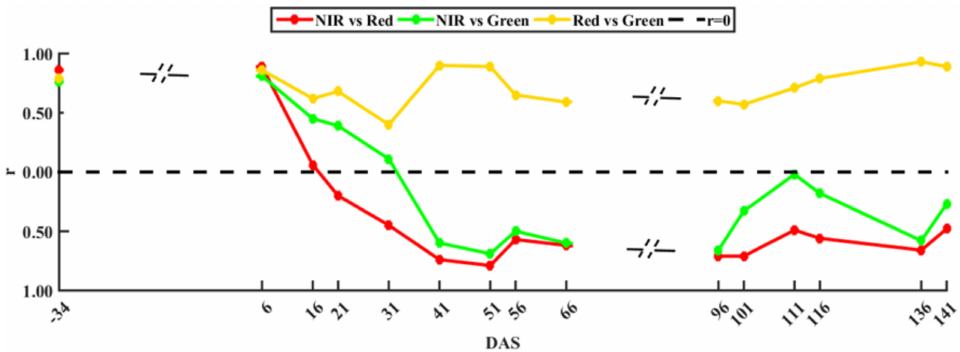
Figure 6. Evolution of correlation coefficient (r) timeseries focusing on NIR against red and green, and red against green ( p < 0.01 for r ≥